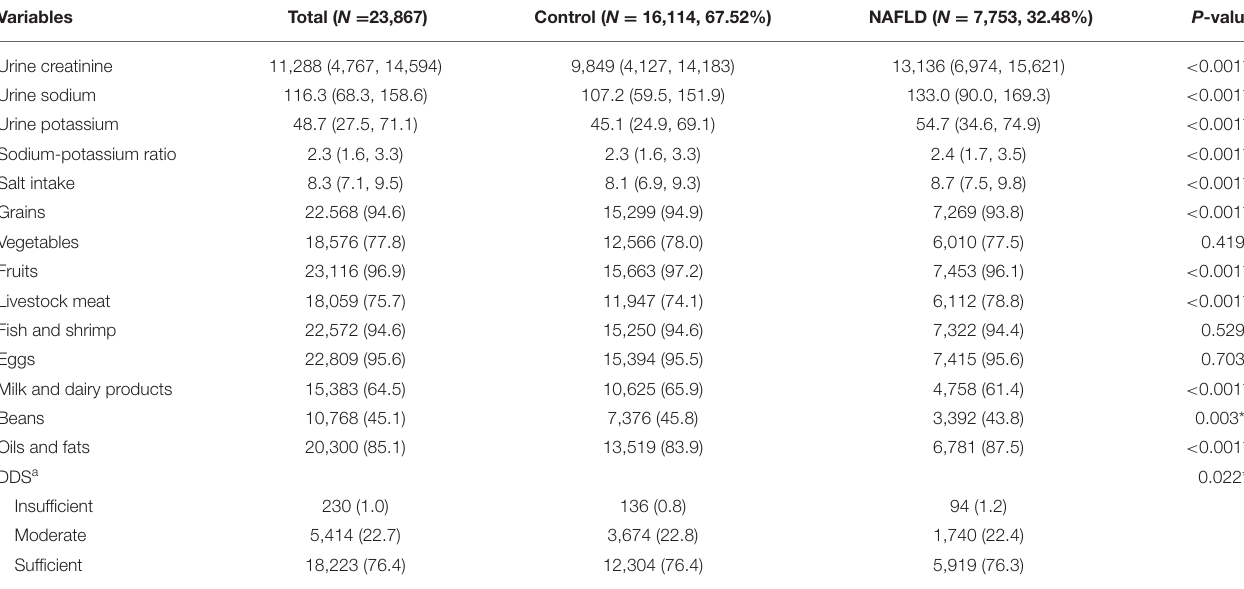
TABLE 2 | Distribution of salt intake and dietary diversity among participants with and without